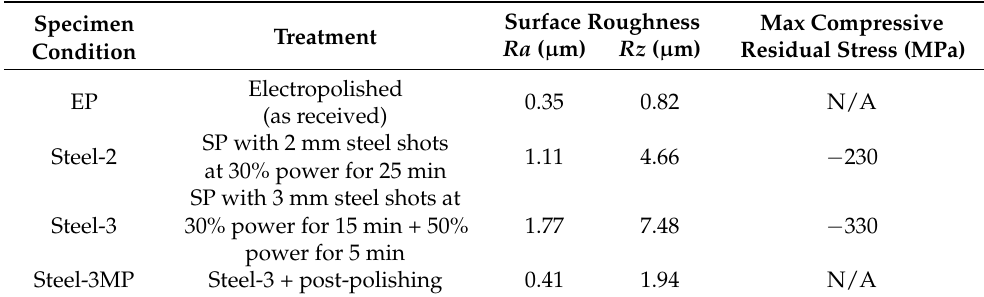
Table 3. Comparison of treatments, surface roughness, and maximum compressive residual stress of 7075-T6 aluminum specimens in as-received (EP) condition and after Steel-2, Steel-3, and Steel-3MP SMAT treatments